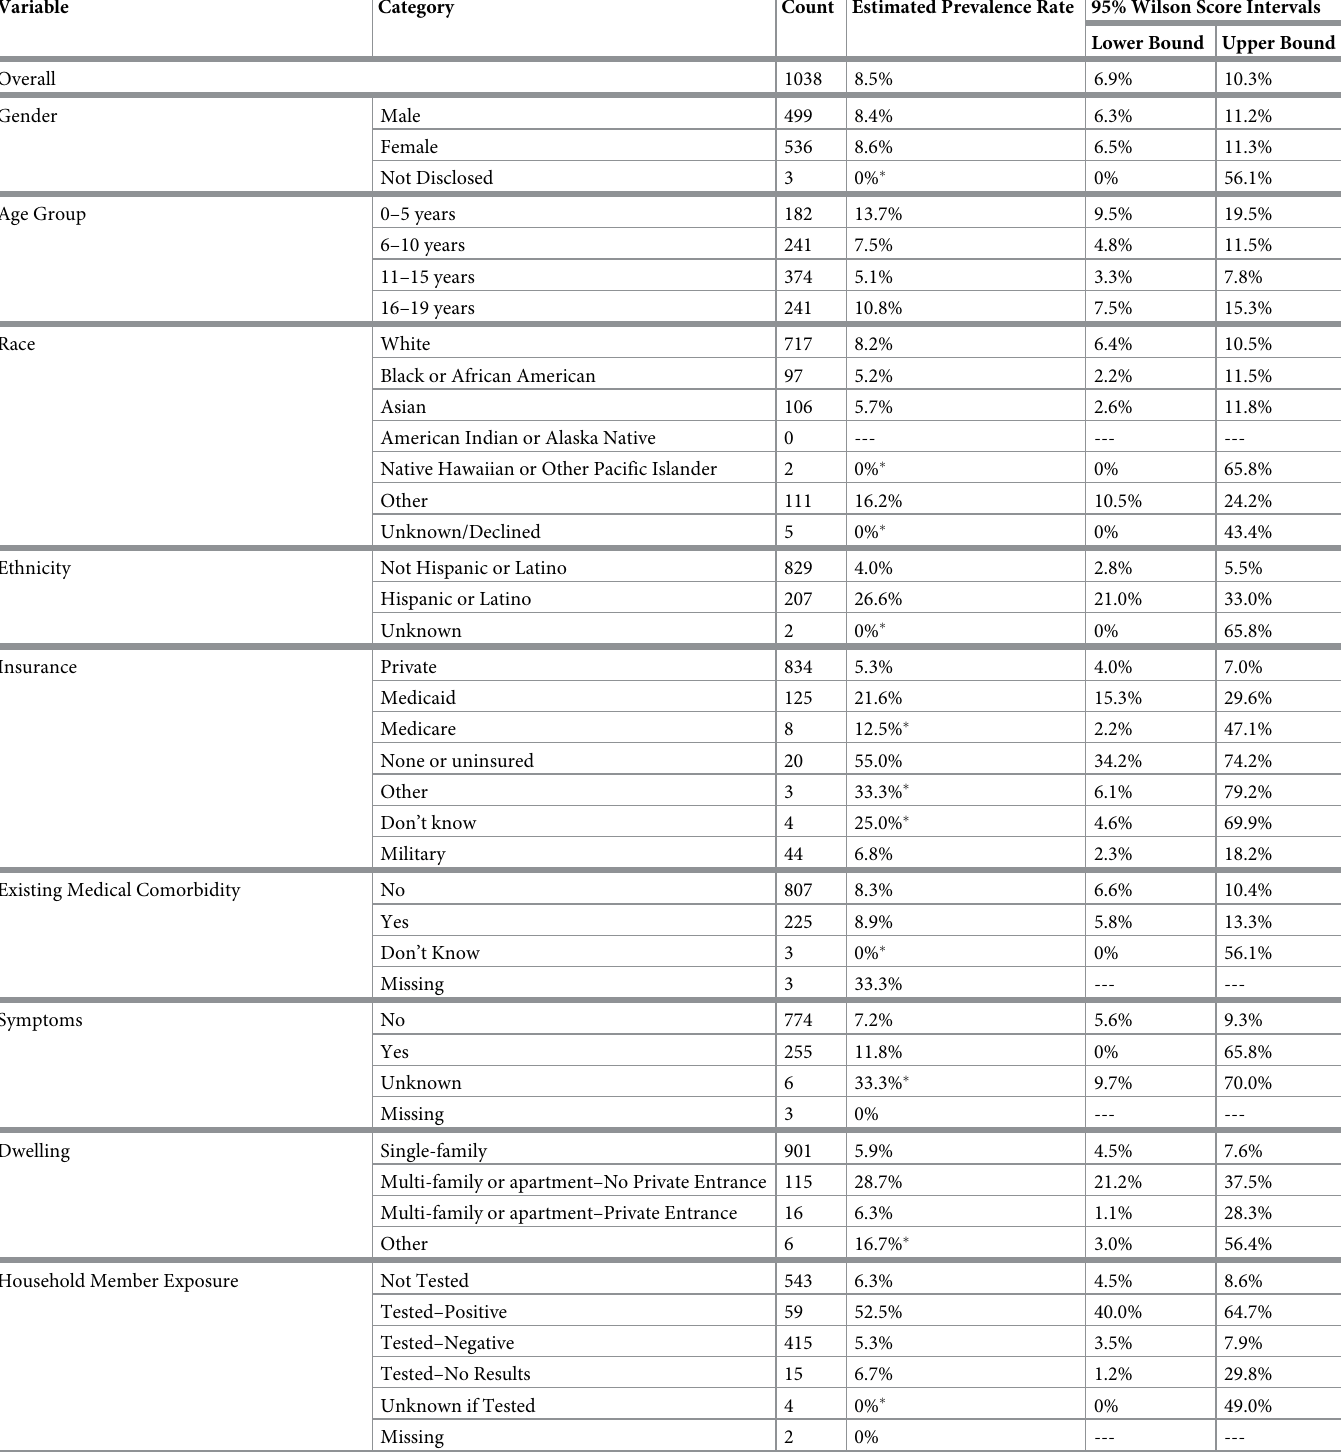
Table 1. Demographic information, prevalence rates, and 95% Wilson score